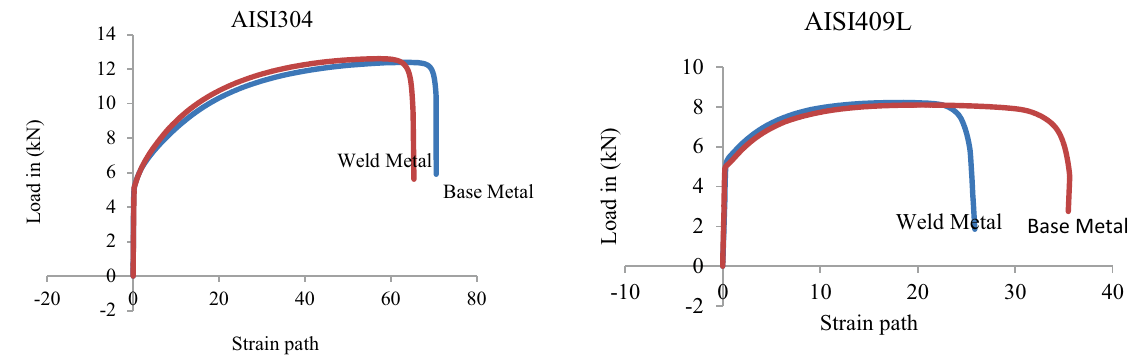
Fig. 9 Strain paths for weld and base metal